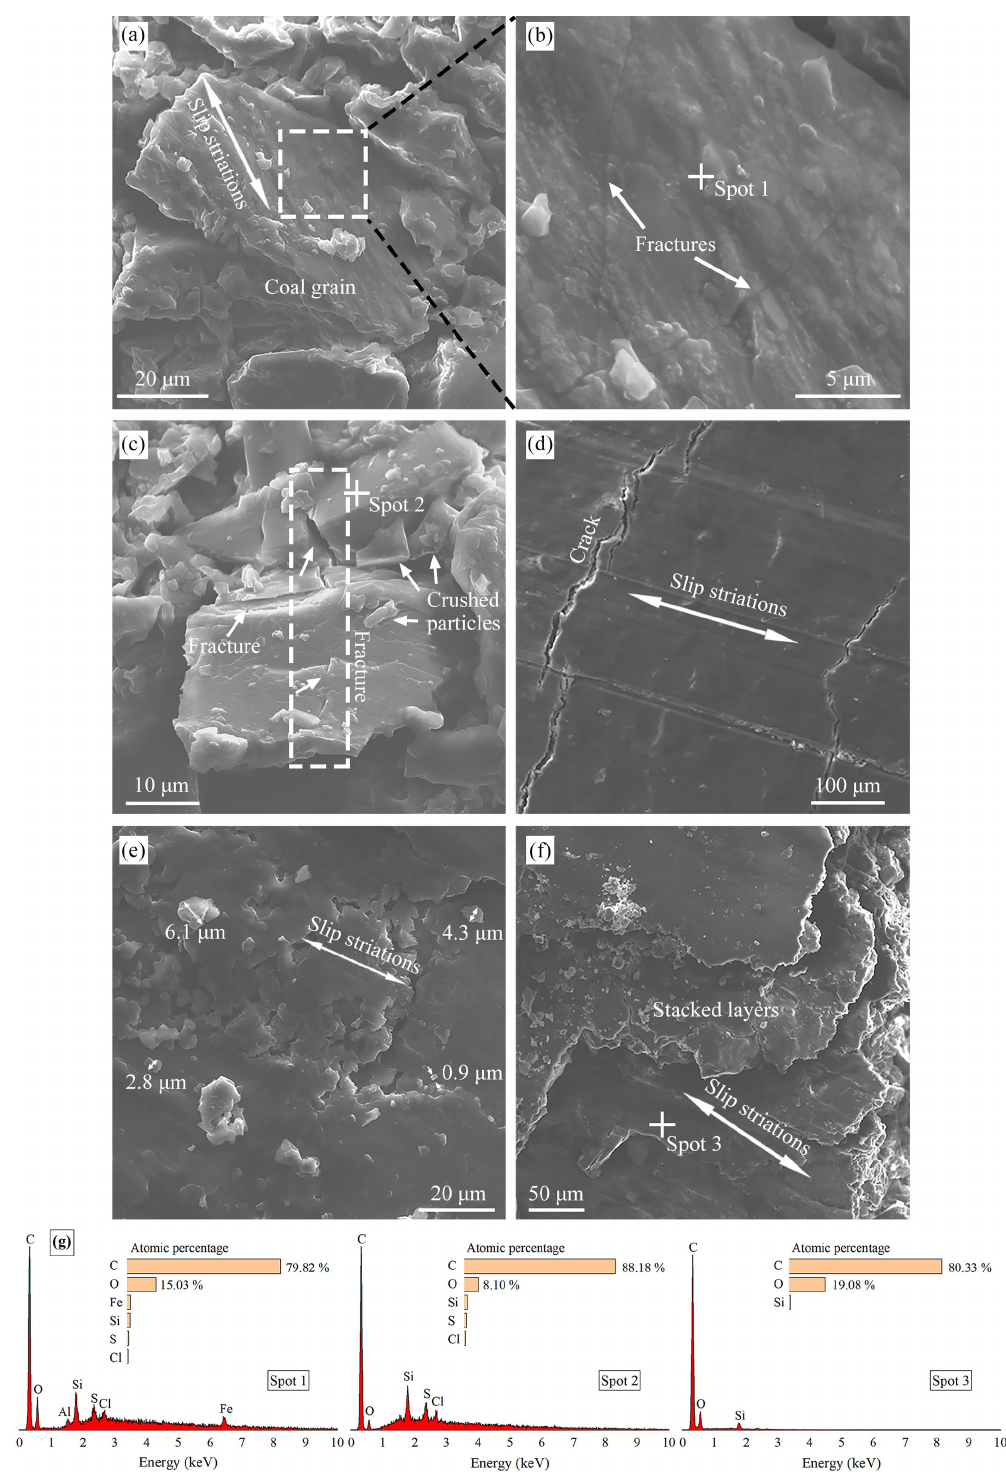
Figure 7. SEM secondary electron images of samples S4 (a, b, c, f) and S5 (d, e) after the direct shear experiments and EDS data (g) for the representative spots. (a) Randomly oriented coal grain with slip striations in the WDZ, located in the cross section of S4. (b) The fractures inside the coal grain shown in (a) . (c) Fractures inside coal grains to form crushed particles. (d) The central region of the shear surface of sample S5, showing cracks and slip striations. (e) Small coal particles ( < ∼ 10µm) in the broken edge of the shear surface. (f) Remarkable layered structure at the margins of the slip zone, likely reflecting an interaction between the PSZ and WDZ as well as the role of the PSZ during the friction process. (g) EDS data for three spots located in S4, showing the elemental composition of the